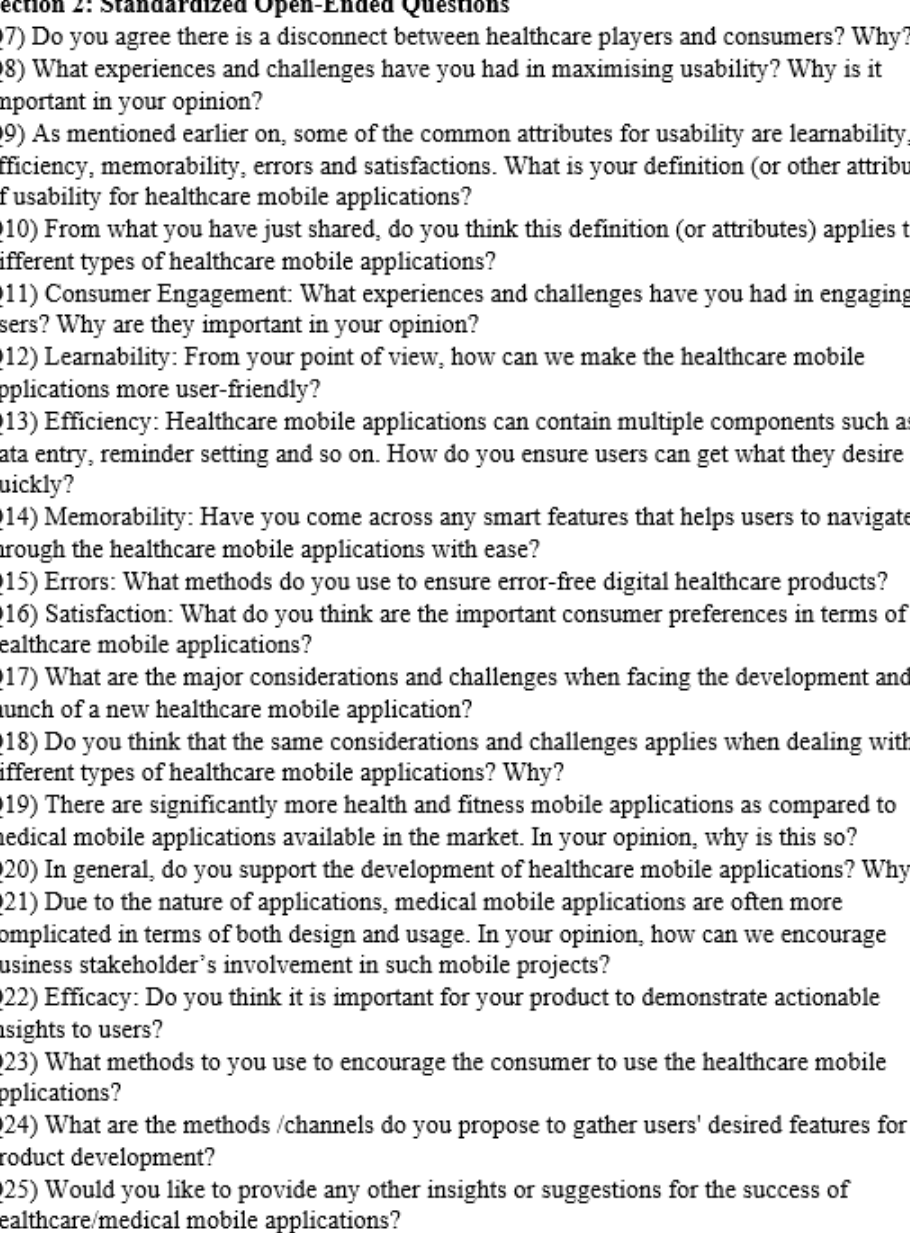
Figure 2. Qualitative study of the interview